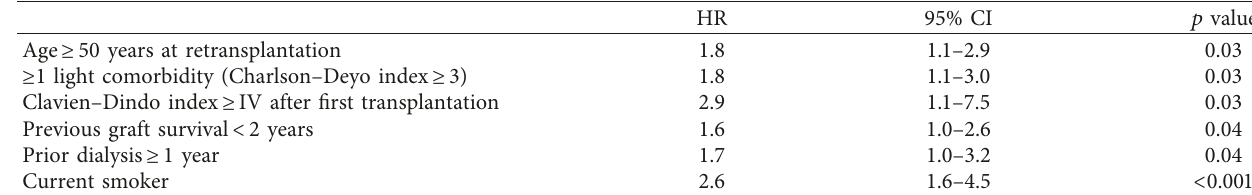
Table 5: Risk factors for graft survival in